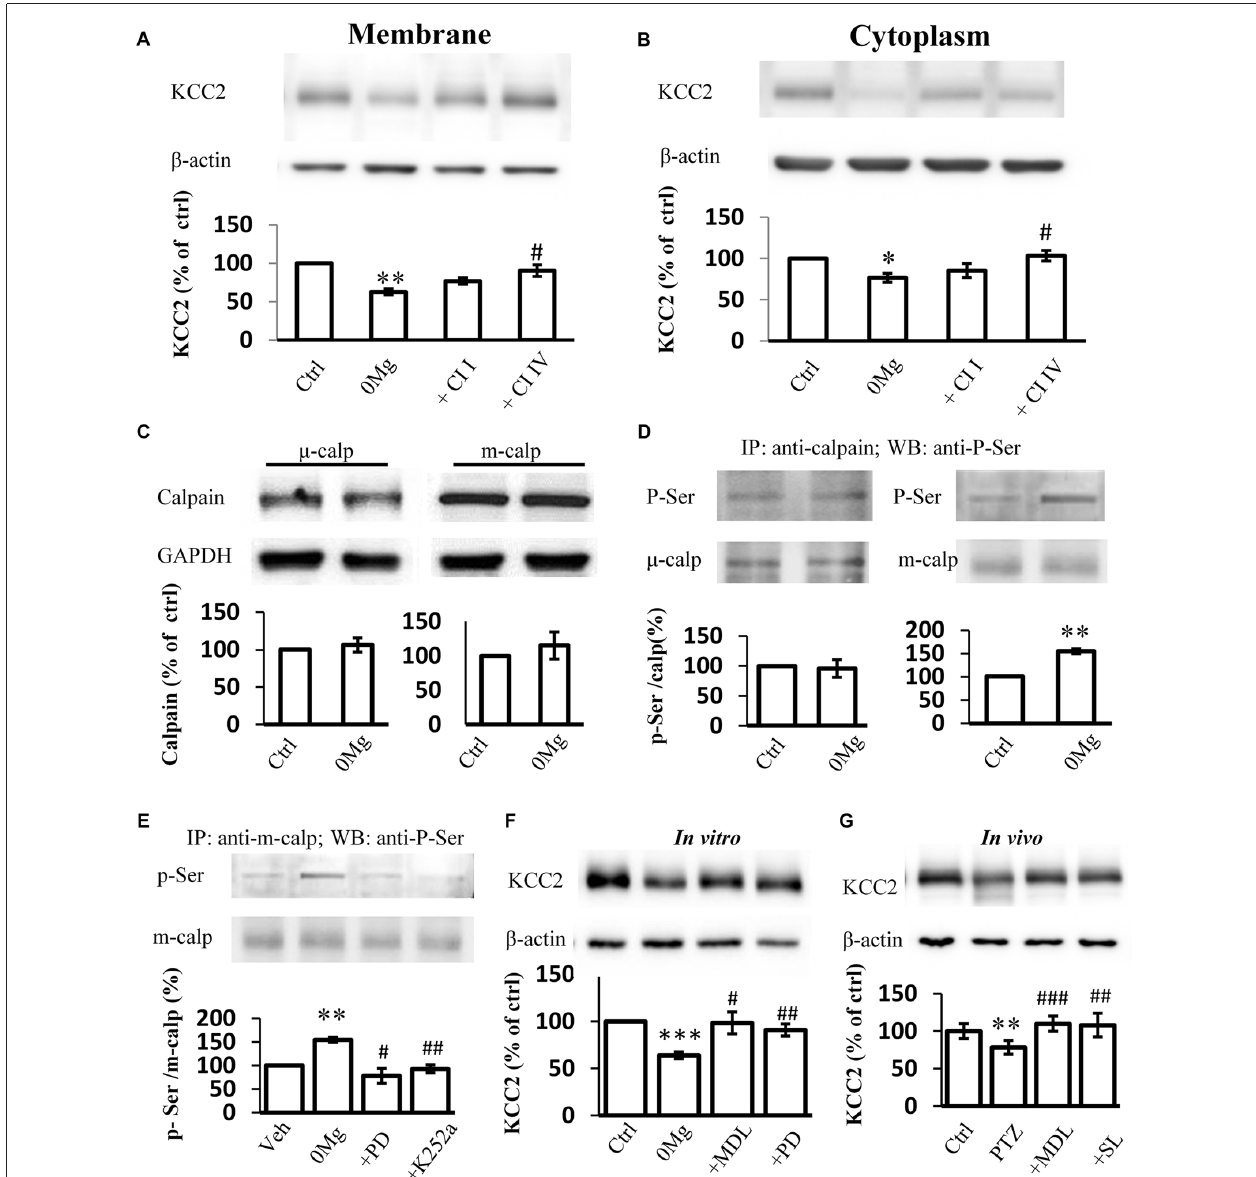
FIGURE 3 | Phosphor-serine activation of m-calpain dominants KCC2 regulation in 0 Mg 2 + seizure model. (A,B) Immunoblotting detection of both plasma membrane (A) and cytoplasm (B) KCC2 expression level change in hippocampal slice 0 Mg 2 + model treated with either µ -calpain or m-calpain selective inhibitor CI I and CI IV, respectively. (C) Expression of either µ - or m-calpain from seizure slices induced by 0 Mg 2 + . (D) Serine phosphorylation level by IP method. Naïve or 0 Mg 2 + treated slices were used as inputs to form immune complex with µ - or m-calpain antibodies and detected by phosphor-serine antibody. Phosphor-serine levels were normalized to corresponded calpain levels. (E) Phosphor-serine level of m-calpain from 0 Mg 2 + , 0 Mg 2 + + PD98059 or K252a treated slices. (F) Immunoblotting showed KCC2 level in 0 Mg 2 + + MDL-28170 or PD98059 treated slices, compared with none treated or 0 Mg 2 + treated alone slices. (G) KCC2